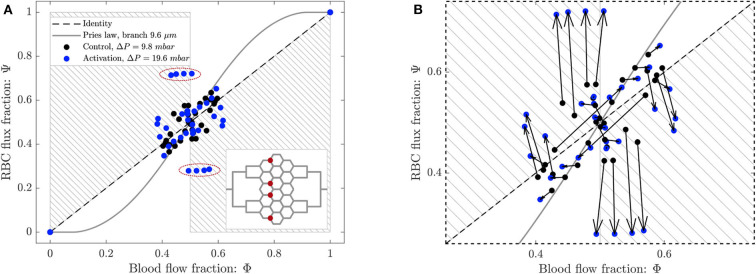
(A) Phase separation results for arteriolar activation. Blood flow fraction vs. RBC flux fraction for the control case (black, ΔP = 9.8 mbar, p = 0 bar) and the activation of an arteriole (blue, ΔP = 19.6 mbar, p = 0 bar). Circles represent data from this study. The gray continuous line is the empirical law from Pries and Secomb (2008). The dashed line is the identity line representing the proportional separation of blood and RBC (no phase separation). Data points in the gray shaded regions indicate an inversion of the Zweifach-Fung effect (Clavica et al., 2016; Shen et al., 2016). In the inset the locations of the four bifurcations with a strong reverse partitioning (circled in red in the Φ − Ψ diagram) are indicated. (B) Magnified region of (A). The arrows indicate the change of the phase separation for each bifurcation.